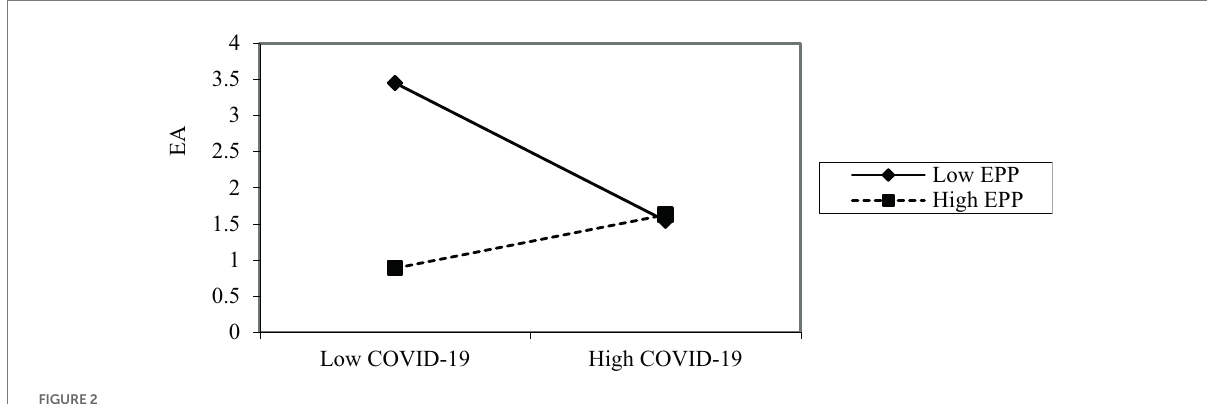
FIGURE 2 The moderating effect of EPP between COVID-19 pandemic and EA.